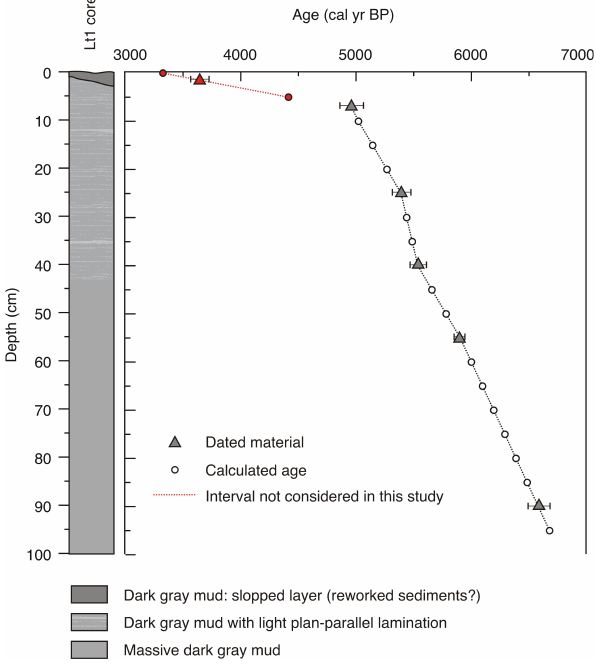
Fig. 3. Depth-age model of the core LT1, Lake Chad, based on six AMS- 14 C measurements ages obtained on bulk organic matter. 14 C ages were calibrated using CALIB 6.0 (Reimer et al.,